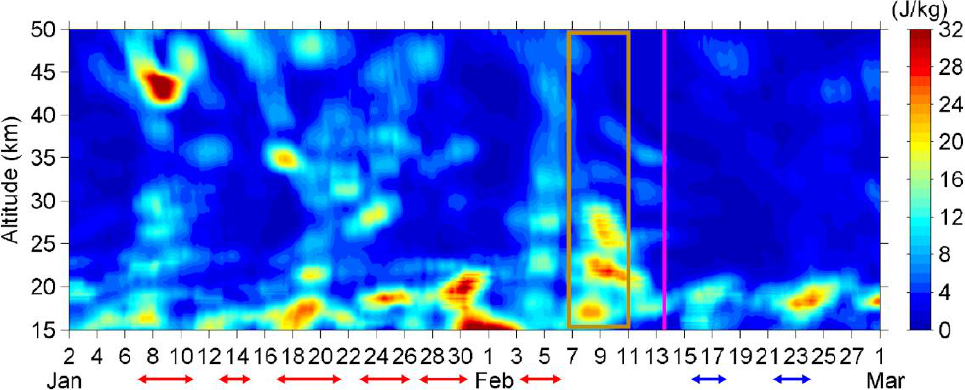
Figure 8. Temporal evolution of altitude profile of potential energy Ep over the epicenter. The vertical magenta line indicates the occurrence time of the first EQ. The red and blue arrows at the bottom of the figure indicate the passing of several weather systems, and the brown rectangle indicates a possible precursor to the first EQ.